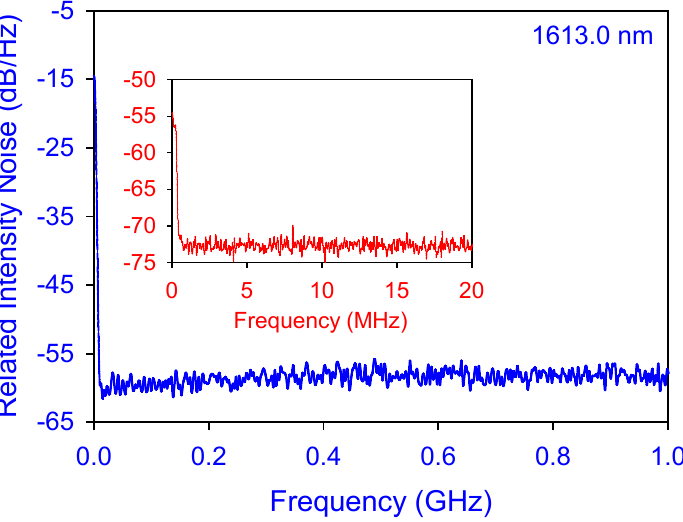
Figure 4. Measured electrical RIN spectrum of 1613.0 nm wavelength in the frequency scope of 0 to 1 GHz. Inset is an observation zoomed in on the spectral range of 0 to 20 MHz.